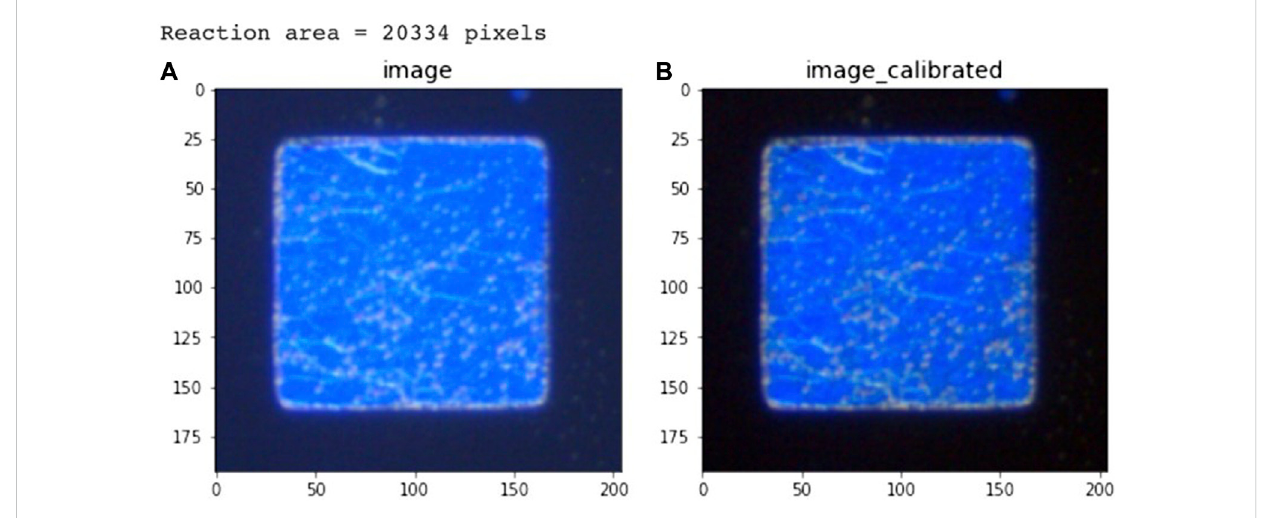
FIGURE 8 Edge detection of (A) the original image and (B) the calibrated image.